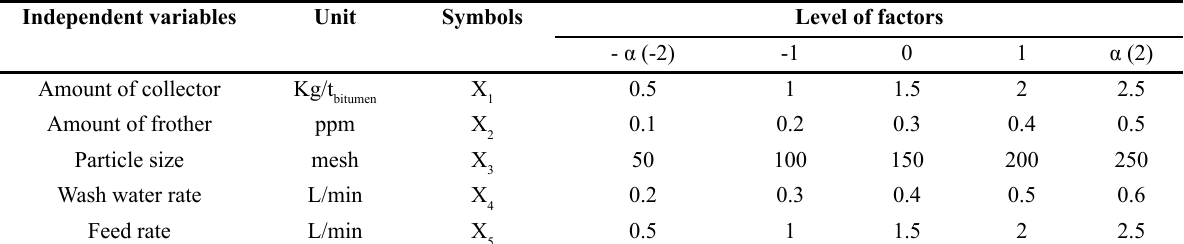
Table 1 . Independent variables and their levels for the central composite design used in the present study. Independent variables Unit Symbols Amount of